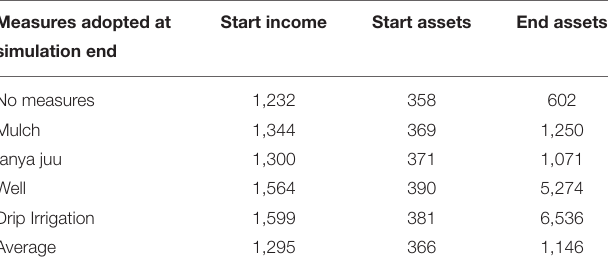
TABLE 2 | Economic profile households.